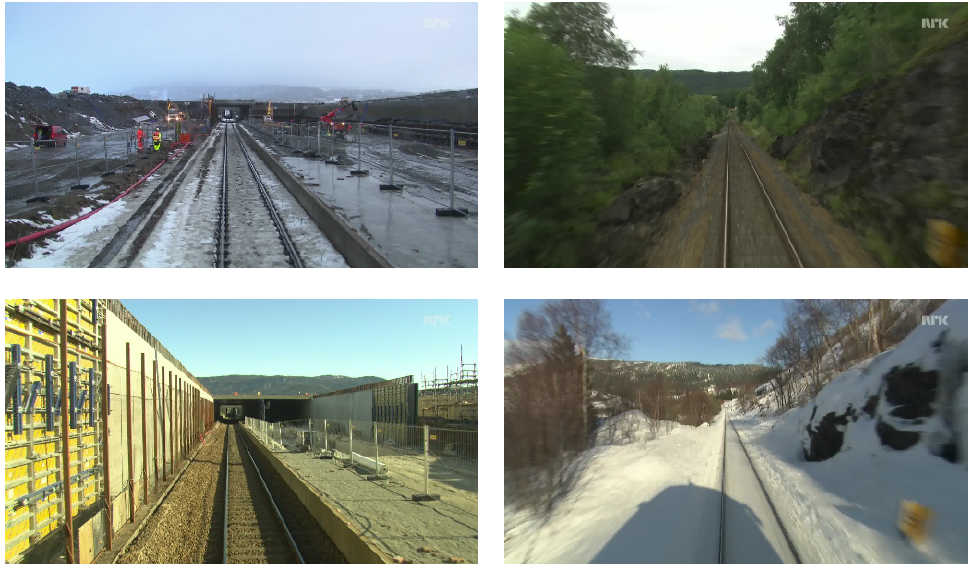
Figure 4. View of Nordland dataset on two different places. Changes in seasons from summer to winter ( right ) and tunnel being built ( left ).